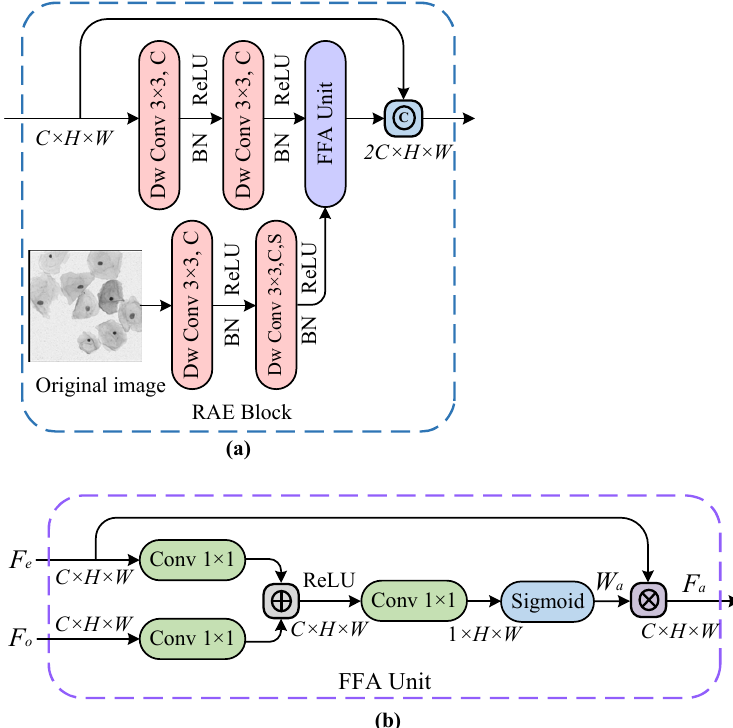
Figure 5. The residual-based attention embedding (RAE) block in ( a ) and the feature fusion attention (FFA) unit in ( b ), where ©, ⊕ and ⊗ denote the feature map concatenation, pixel-wise addition, and pixel-wise multiplication operations, respectively. And H , W , C , and S represent the height, width, number of channels, and convolution stride of the feature map,